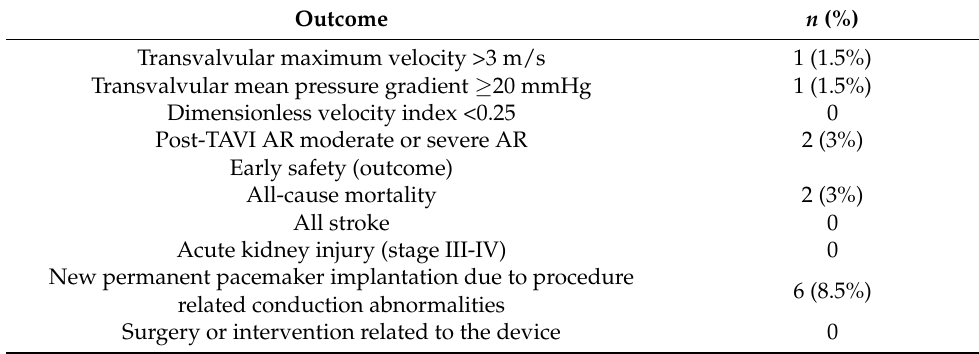
Table 4. 30 days hemodynamic and clinical outcomes (device success at 30-day) of the Myval THV in BAV.